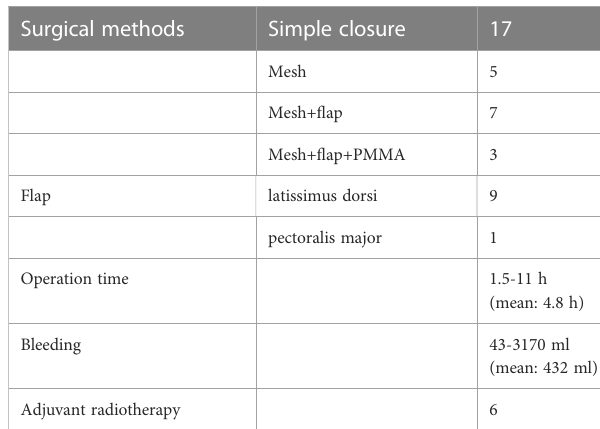
TABLE 3 Surgical data 2.